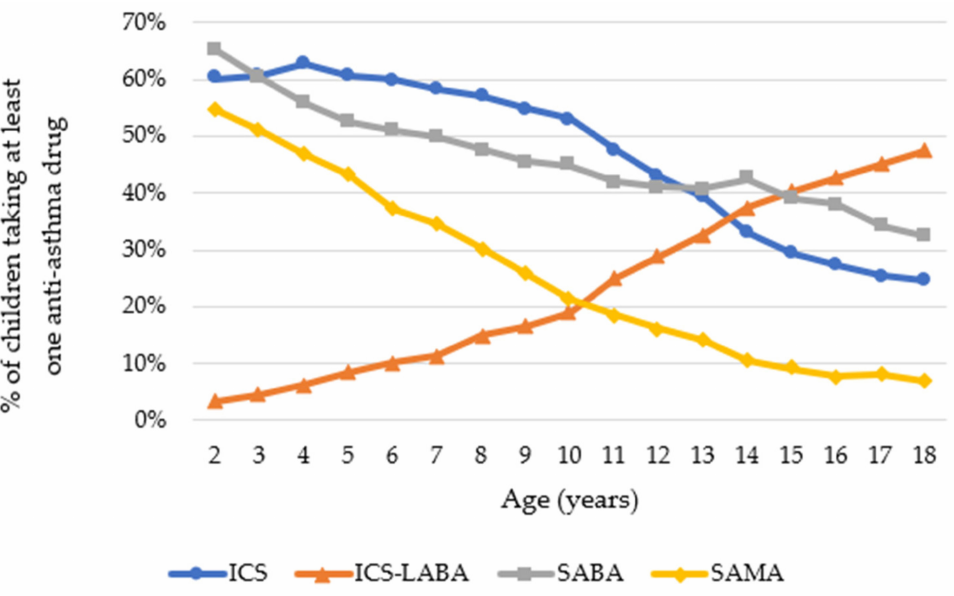
Figure 2. Proportion of children taking asthma medications in 2018 according to pharmacological